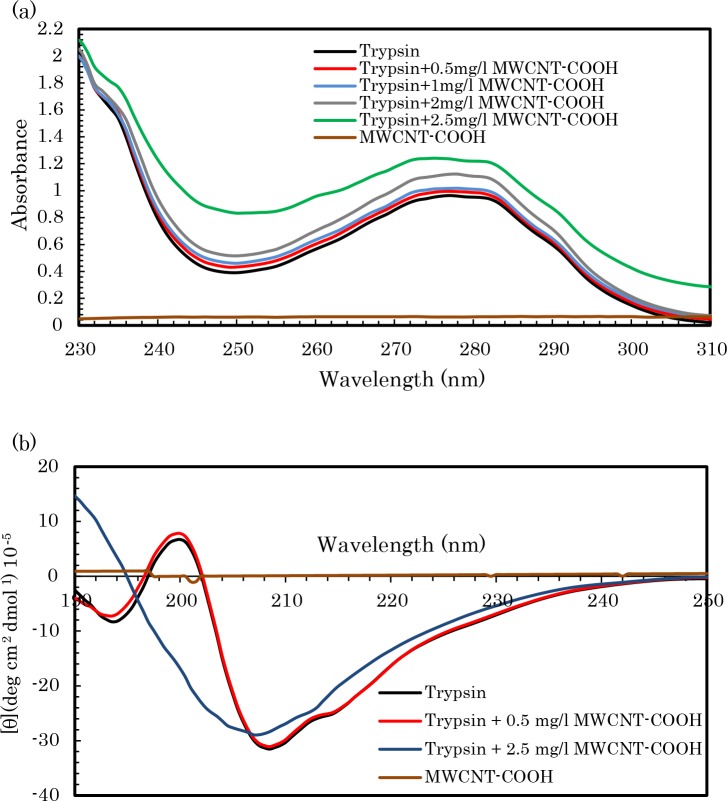
(a) UV–visible absorption spectra of trypsin. C
trypsin = 2.0 × 10−5 M, CCNTs are in the total volume of the reaction mixture; pH 8.0, T = 298 K. (b) CD spectra of trypsin and COOH-f-MWCNTs-pTry mixtures. C
trypsin = 1 × 10−4 M. CCNTs are in the total volume of the reaction mixture; pH 8.0, T = 298 K. Data are shown as mean values ± S.D.